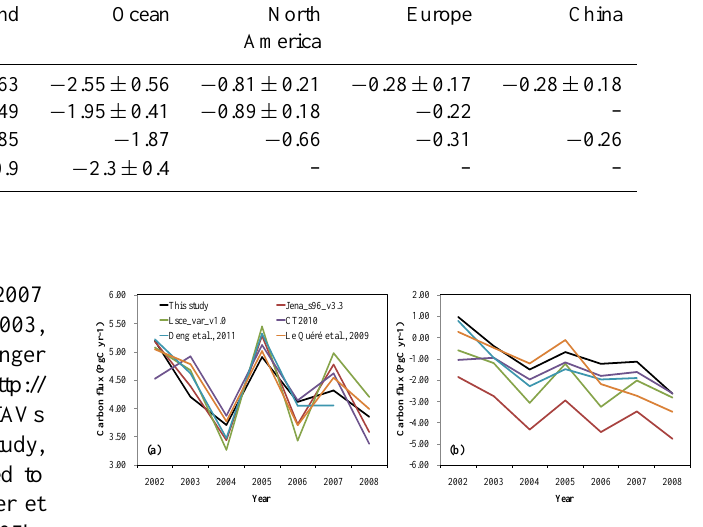
Fig. 5. Inter-annual variation of global carbon fluxes ( a , global net carbon fluxes; b , terrestrial ecosystem carbon fluxes, land sinks + biomass burning); for details of the inversion systems of Lsce_var_v1.0, Jena_s96_v3.3 and CT2010, please refer to Chevallier et al. (2010), Rödenbeck (2005), and Peters, et al. (2007), respectively.